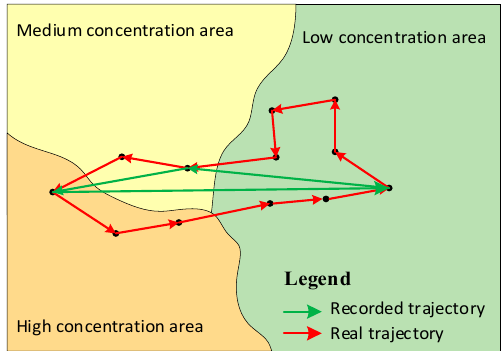
Figure 1. Illustration of the influence of the data sparsity problem in human movement data.